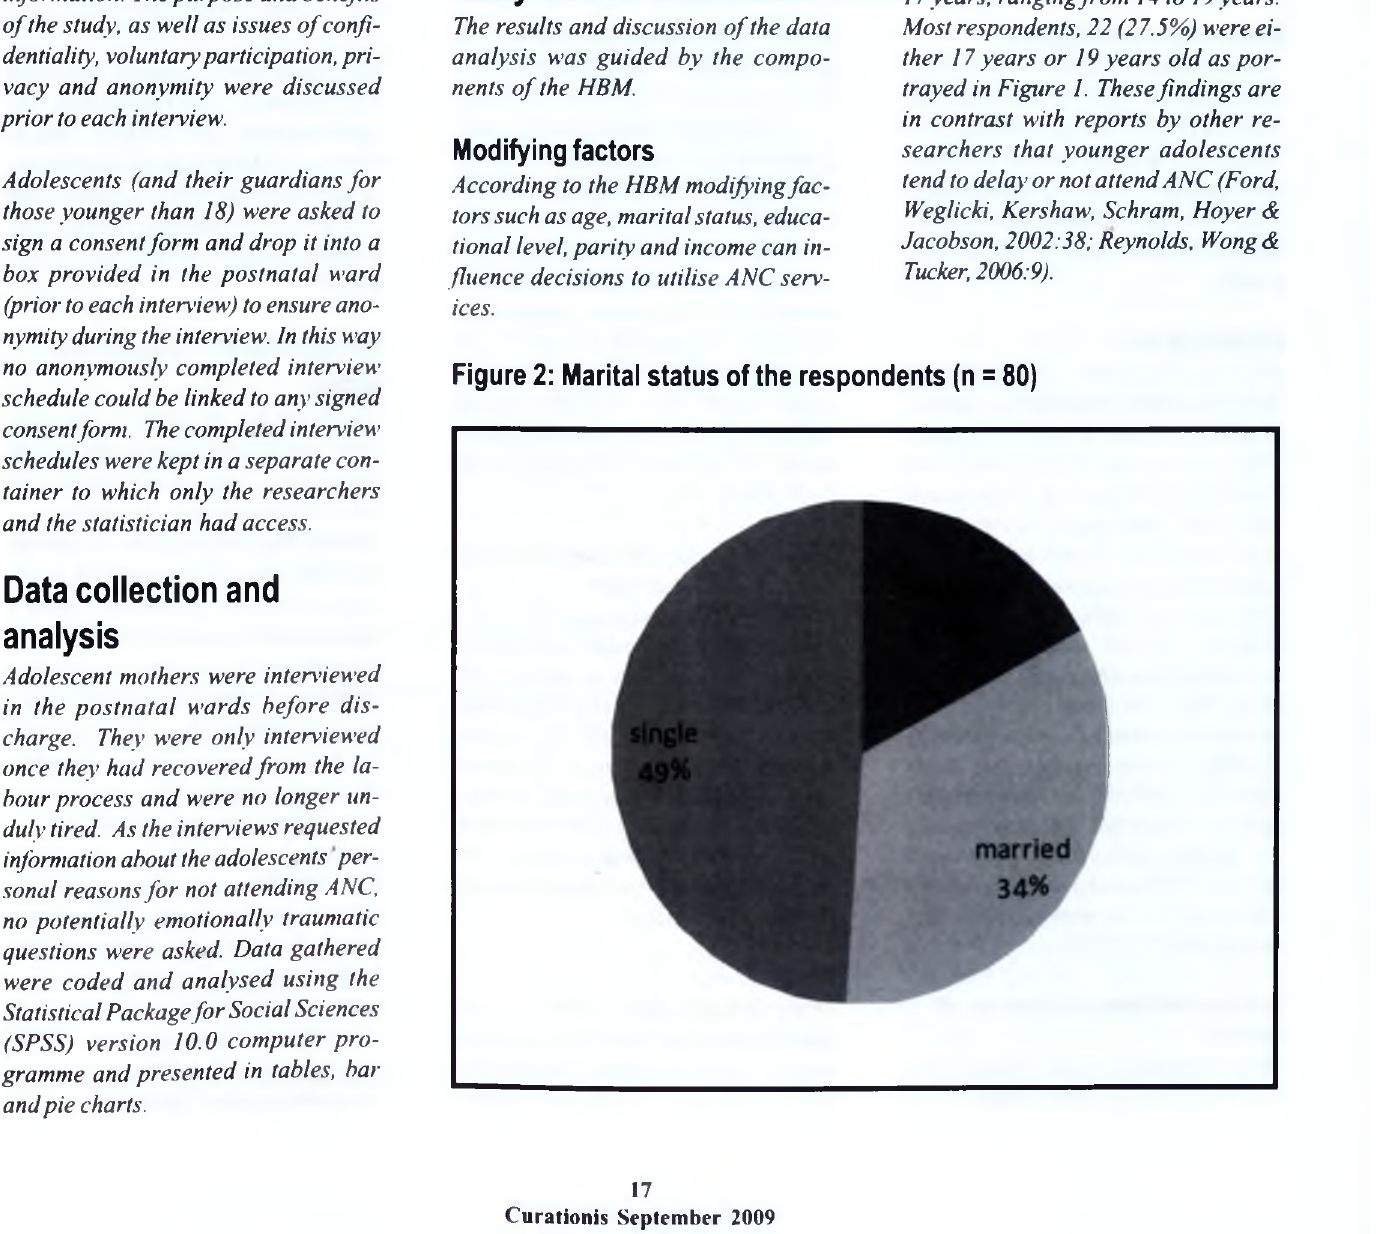
Figure 2: Marital status of the respondents (n =